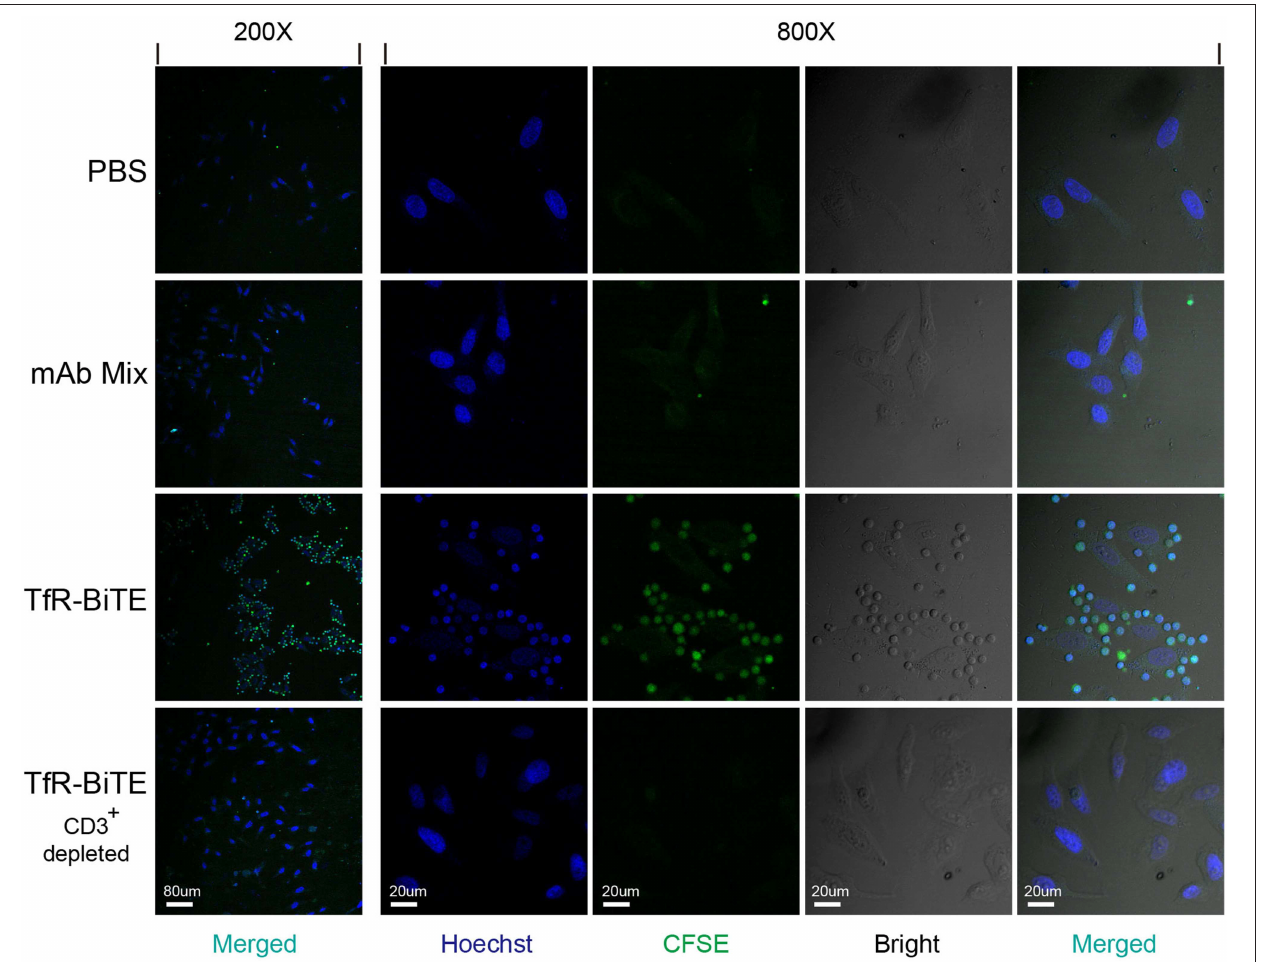
FIGURE 2 | TfR-BiTE is an engager between targets and effector cells. 3 × 10 4 HepG2 cells adherent to coverslips were incubated with CFSE-labeled PBMCs depleted with or without CD3 + cells in the presence of TfR-BiTE or mAb Mix for 80min. After thorough washes, the cells on coverslips were fixed and stained with Hoechst. Rosette-like configurations were examined using a confocal